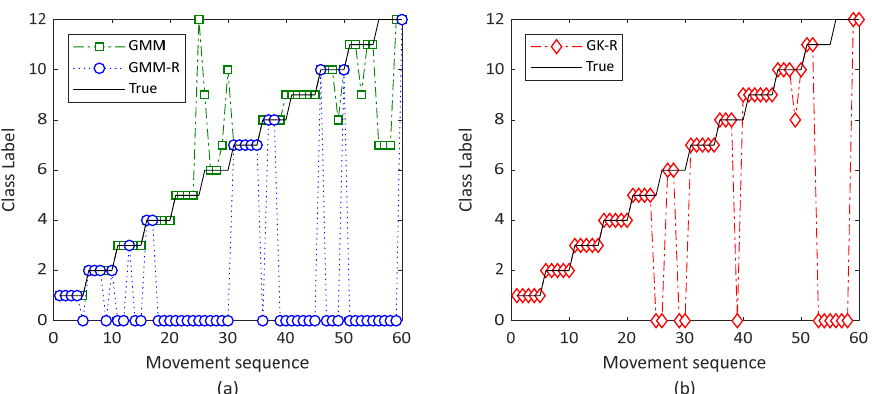
Figure 6. Movement recognition by proposed algorithms. ( a ) Comparison of GMM classifier and GMM ‐ R classifier. ( b ) Result of GK ‐ R classifier.